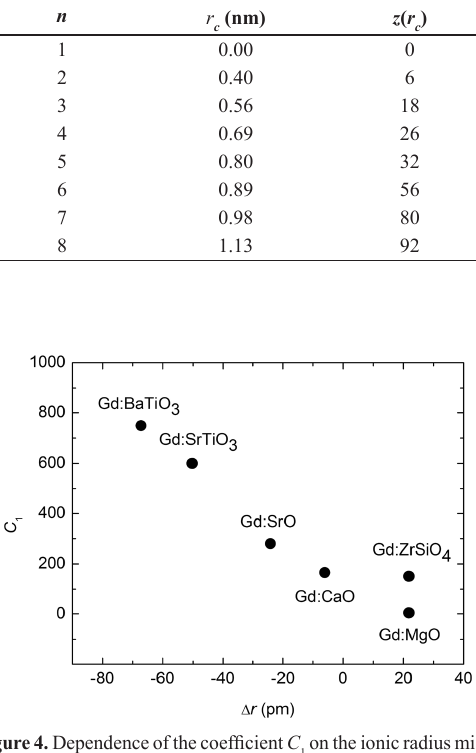
, z ( r ), a , C and Δ r for the Gd 3+ ion in C C 1